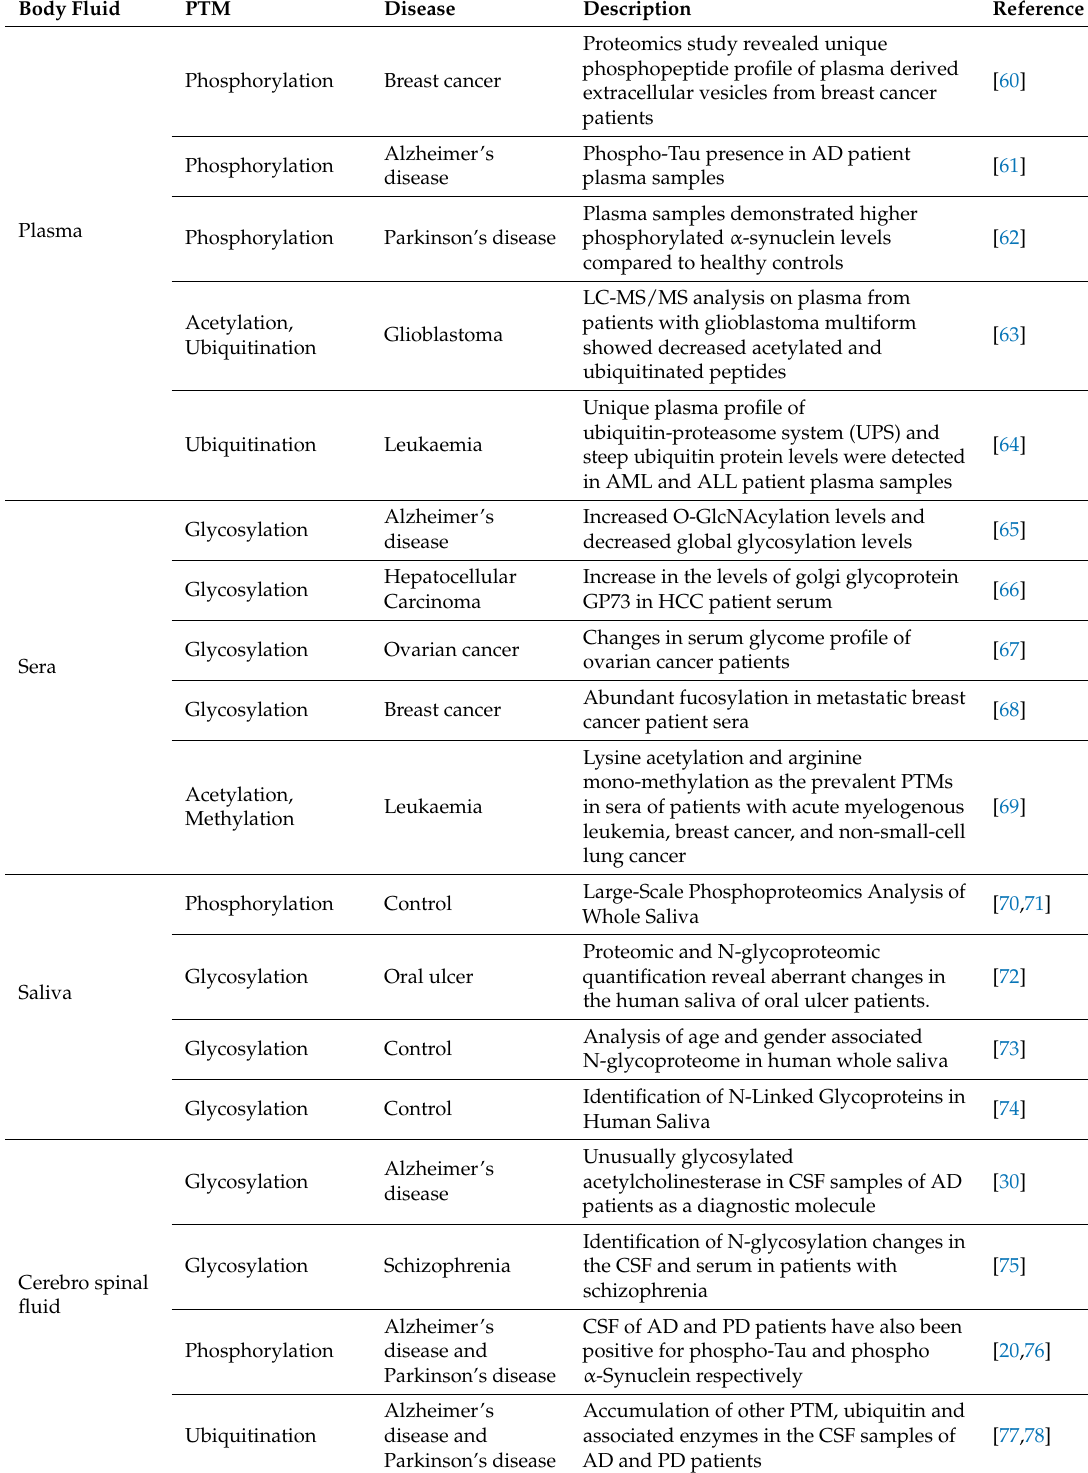
Table 1. Examples of PTM studies for various clinically relevant biological